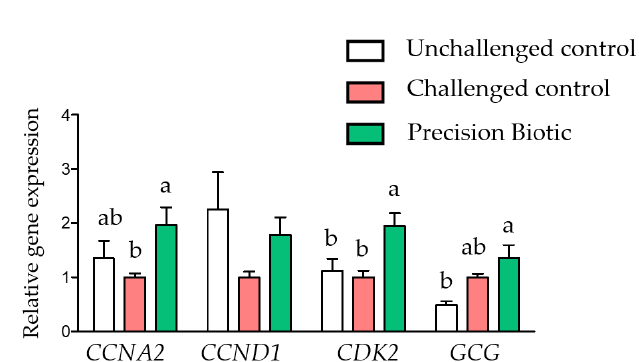
Figure 4. A precision biotic influenced expression of ileal cell cycling gene markers at 21 days of age. Relative expression of genes involved in cell cycling ( CCNA1 , CCND1 , and CDK2 ) and the pro- glucagon gene GDG that encodes for glucagon and glucagon-like peptides. One-way ANOVA with Tukey post-hoc test has been performed on all results; statistically significant differences ( p < 0.05) are indicated by different letters on the bars.